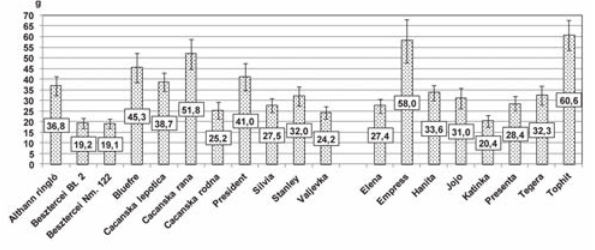
Figure 2. Mean mass of fruits and the standard error of plum varieties